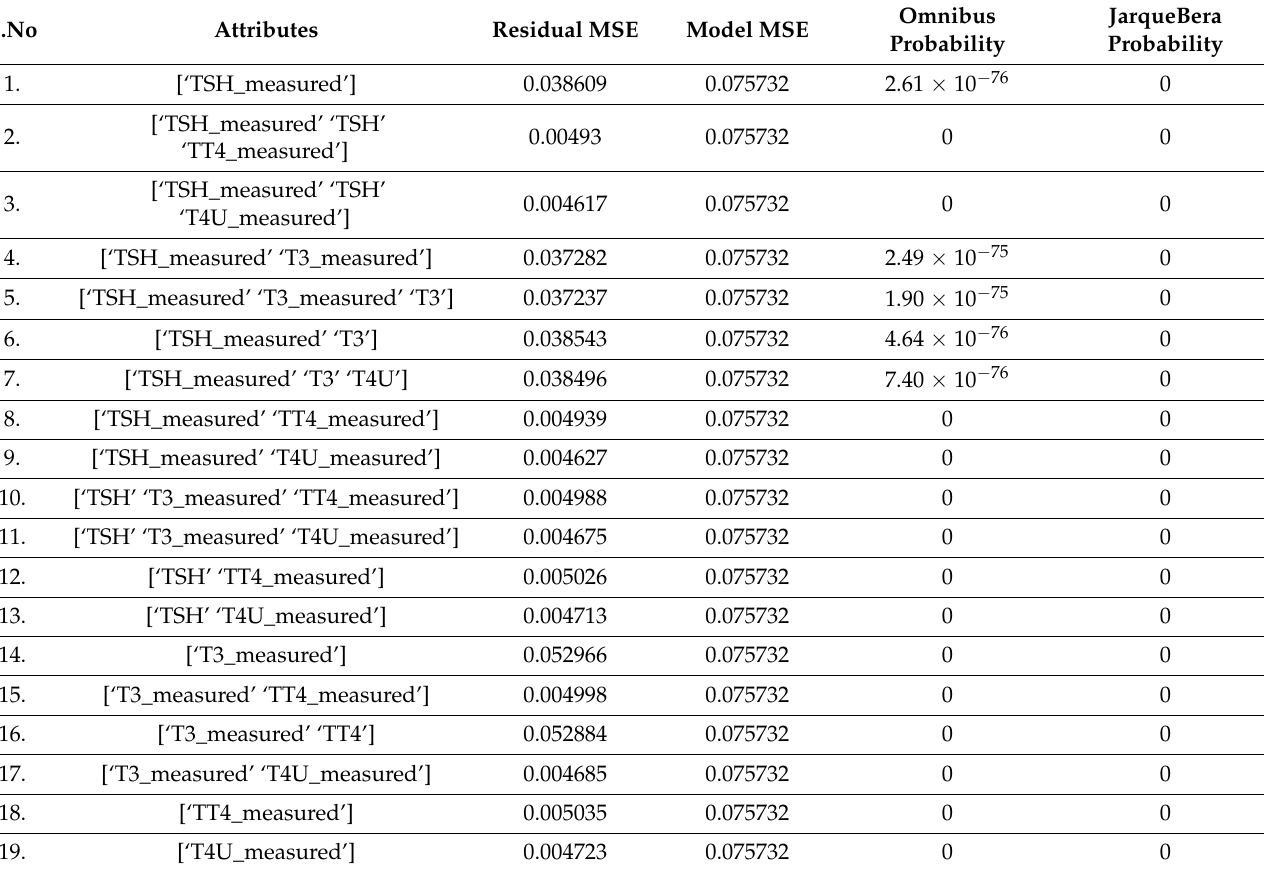
Table 28. OLS features of the significant subset attributes of the hypothyroid